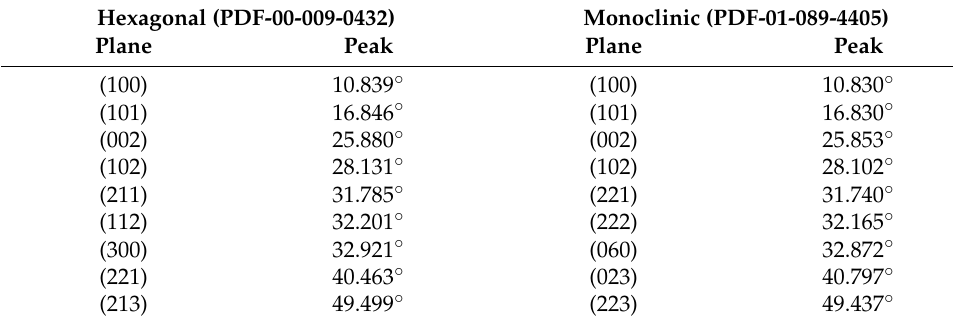
Table 4. Main planes and angles of the HAp hexagonal and monoclinic phases.